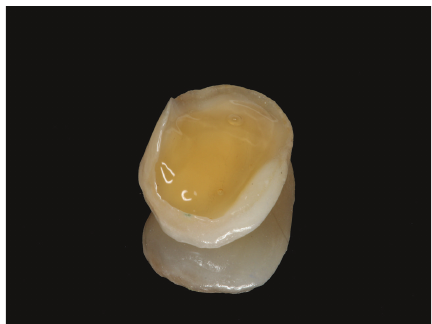
Figure 13: Removal of resin cement excesses.